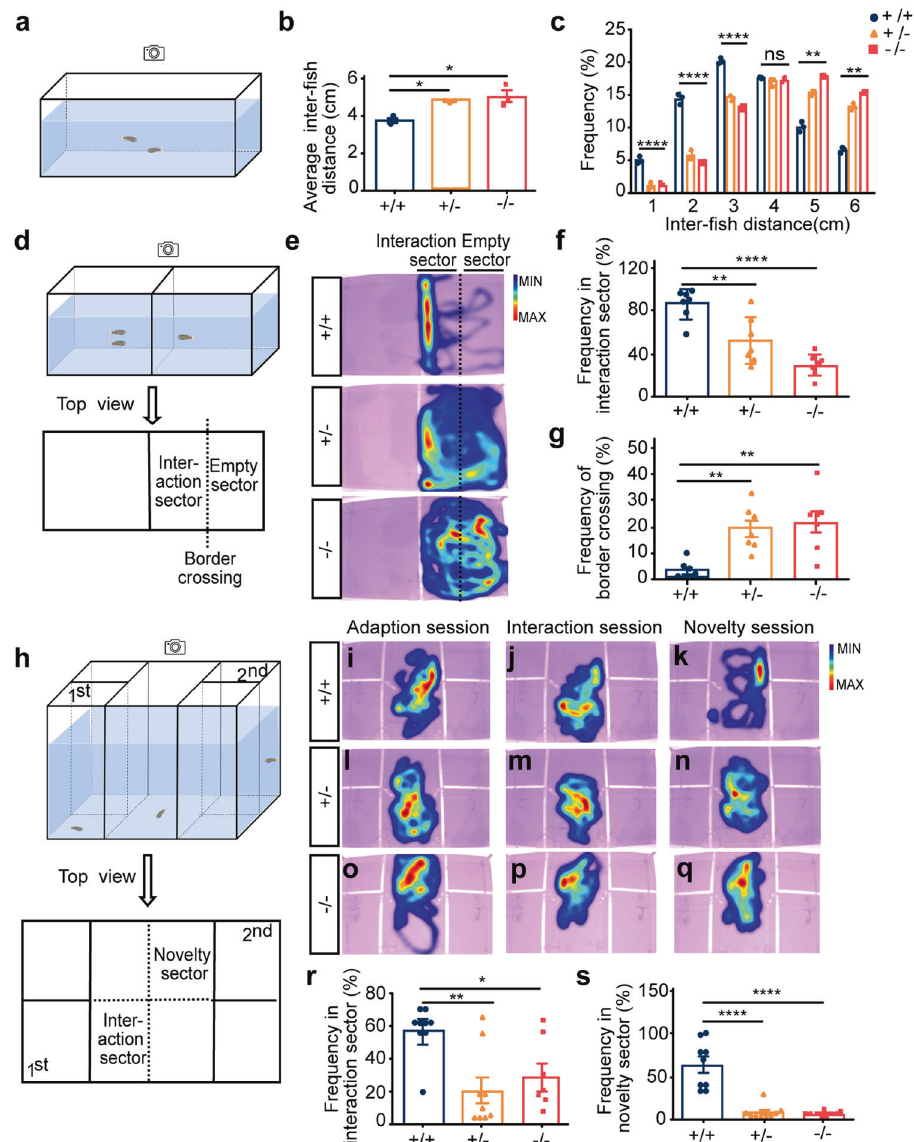
Fig. 2 Scgn + / − and scgn − / − zebra fi sh show autistic-like behavior. a Schematic diagram of shoaling test. Inter- fi sh distance is recorded; b S cgn + / − and scgn − / − adult zebra fi sh (4 month old) displayed a signi fi cantly increased- fi sh distance in shoaling test, relative to their wild-type siblings. + / + : scgn + / + ; + / − : scgn + / − ; − / − : scgn − / − . * p < 0.05. P- values were calculated using one-way ANOVA, Tukey ’ s multiple comparisons test. c Frequency at different inter- fi sh distance in shoaling test. + / + : scgn + / + ; + / − : scgn + / − ; − / − : scgn − / − . **** p < 0.0001, *** p < 0.001, ** p < 0.01, * p < 0.05. ns not signi fi cant. P -values were calculated using one-way ANOVA, Tukey ’ s multiple comparisons test. d Schematic diagram of two- sector social interaction test. Two stimulus zebra fi sh were placed in the left chamber. Border crossing is de fi ned as moving from the interaction sector to the empty sector, or vice versa. e Heatmaps show that scgn + / + zebra fi sh displayed remarkable higher frequency close to the stimulus zebra fi sh than scgn + / − and scgn − / − zebra fi sh. Warmer colors (red) indicate a greater amount of time spent exploring by the zebra fi sh. f Frequency of test fi sh in the interaction sector. **** p < 0.0001, ** p < 0.01. P -values were calculated using one-way ANOVA, Tukey ’ s multiple comparisons test. g Frequency of border crossing between the interaction and the empty sectors. ** p < 0.01. P -values were calculated using one-way ANOVA, Tukey ’ s multiple comparisons test. h Schematic diagram of a fi ve-chamber social interaction tank for the visually mediated social preference test (VMSP). i – k Heatmap of scgn + / + zebra fi sh in the adaption session ( i ), interaction session ( j ), and social novelty session ( k ). l – n Heatmap of scgn + / − zebra fi sh in the adaption session ( l ), interaction session ( m ), and social novelty session ( n ). o – q Heatmap of scgn − / − zebra fi sh in the adaption session ( o ), interaction session ( p ), and social novelty session ( q ). r Frequency in the interaction sector during the interaction session of scgn + / + , scgn + / − , and scgn − / − zebra fi sh. ** p < 0.01, * p < 0.05. P -values were calculated using one-way ANOVA, Tukey ’ s multiple comparisons test. s Frequency in the novelty sector during the novelty session of scgn + / + , scgn + / − , and scgn − / − zebra fi sh. **** p < 0.0001, P -values were calculated using one-way ANOVA, Tukey ’ s multiple comparisons test. All experiments were performed in three repetitions fi ndings from our structural analysis, suggesting that the R79W length in the MO + R79W group (0.0995 mm) was similar to that of substitution would disrupt the normal function of SCGN. Thus, we the MO group (0.0985 mm) and was substantially shorter than concluded the p.R79W variant discovered in the ASD patient those in the MO + WT (0.1158 mm) or the MO + R79Q represents a loss-of-function mutation of SCGN . (0.1053 mm) embryos (Fig. 3j). These data corresponded to